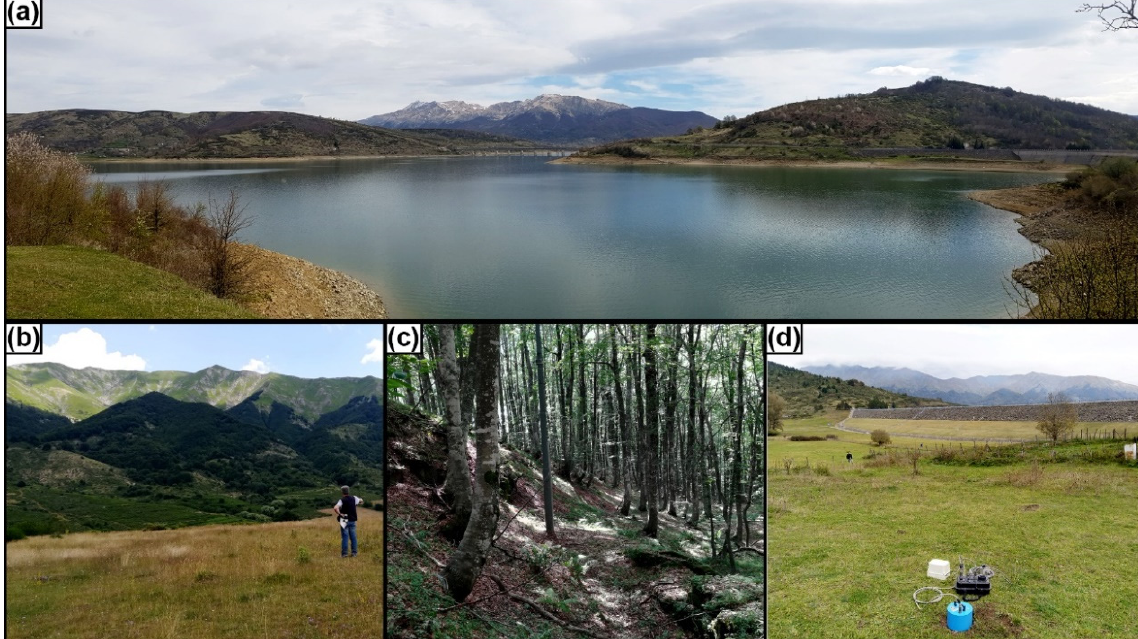
Figure 2. Panel of photographs of the study area: ( a ) Panoramic view of Lake Campotosto with, on the right, the Sella Pedicate dam and, in background, the Gorzano Mt. fault system; ( b ) view of the Gorzano Mt., where the triangular facets roughly indicate the Gorzano Mt. fault trend; ( c ) lowered ground surface indicating a main trench in the upper part the deep-seated gravitational slope deformations DsGSD (ID.9) of Figures 4 and 5; ( d ) seismic ambient noise measurement carried out in the Poggio Cancelli valley with, in background, the Poggio Cancelli dam.